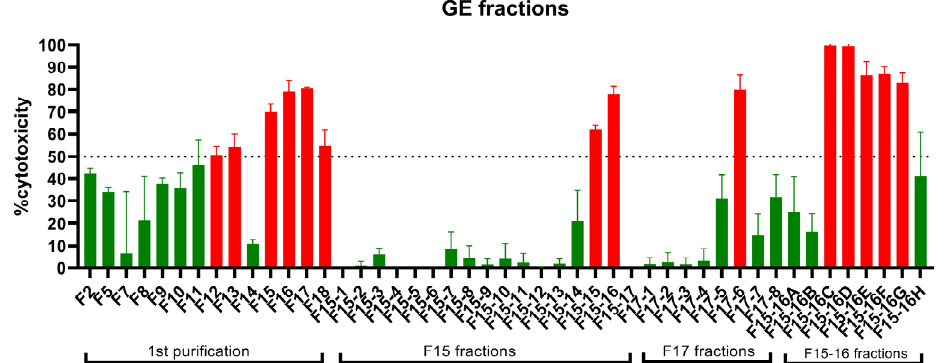
Figure 2. MTS assay screening of partially purified A. muricata ethyl acetate fractions after the first, second, and third purification steps. Fractions that are exhibited 50% cytotoxicity are colored red, while fractions below that are colored green.